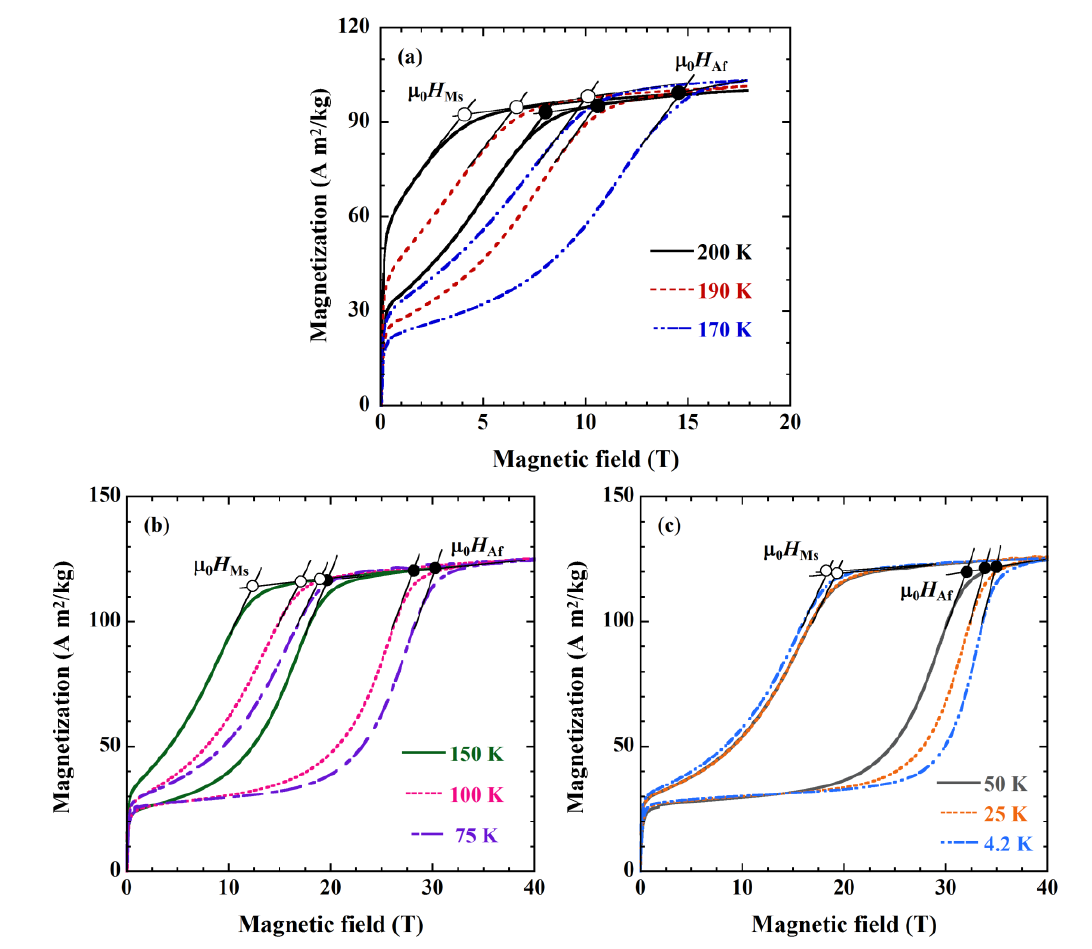
Figure 3. Magnetization curves measured at various temperatures for Ni 41 Co 9 Mn 39 Sb 11 alloy. ( a ) is measured under static magnetic fields up to 18 T, and ( b ) and ( c ) are under pulsed magnetic fields up to 40